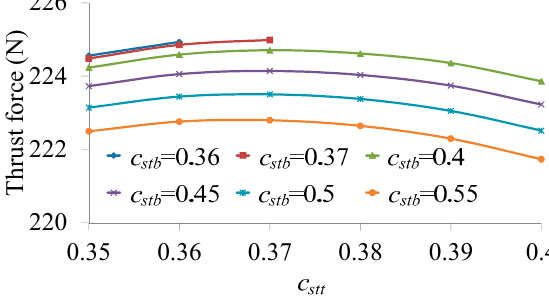
Figure 12. Average thrust force value with different c stt and c stb .